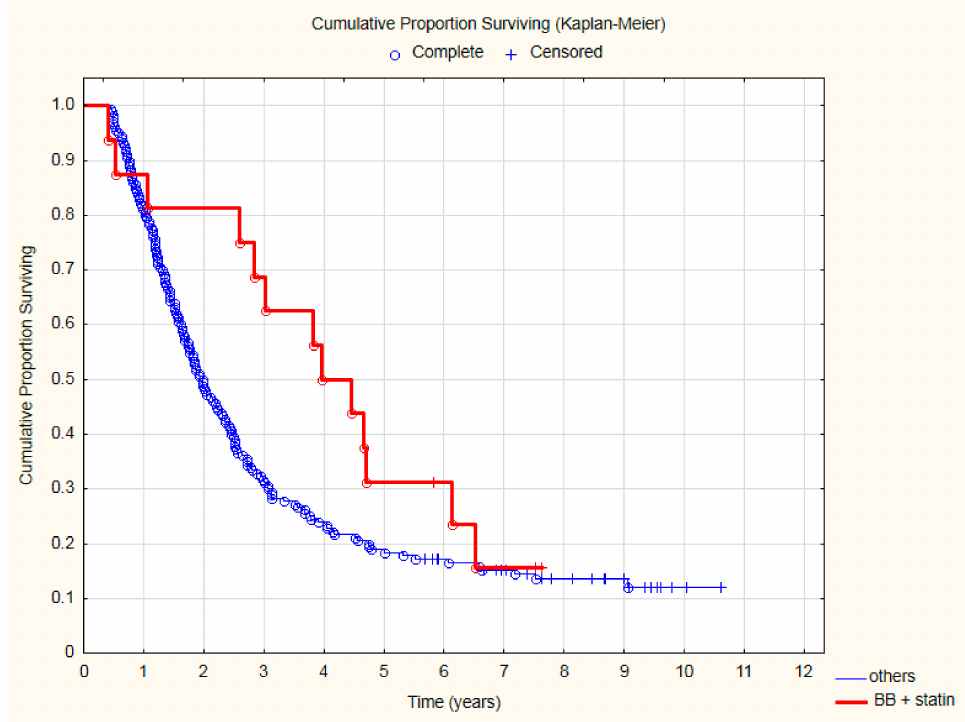
Figure 3. The comparison of overall survival in patients treated with beta-blocker (BB) and statin due to CVD and other patients after CRT.